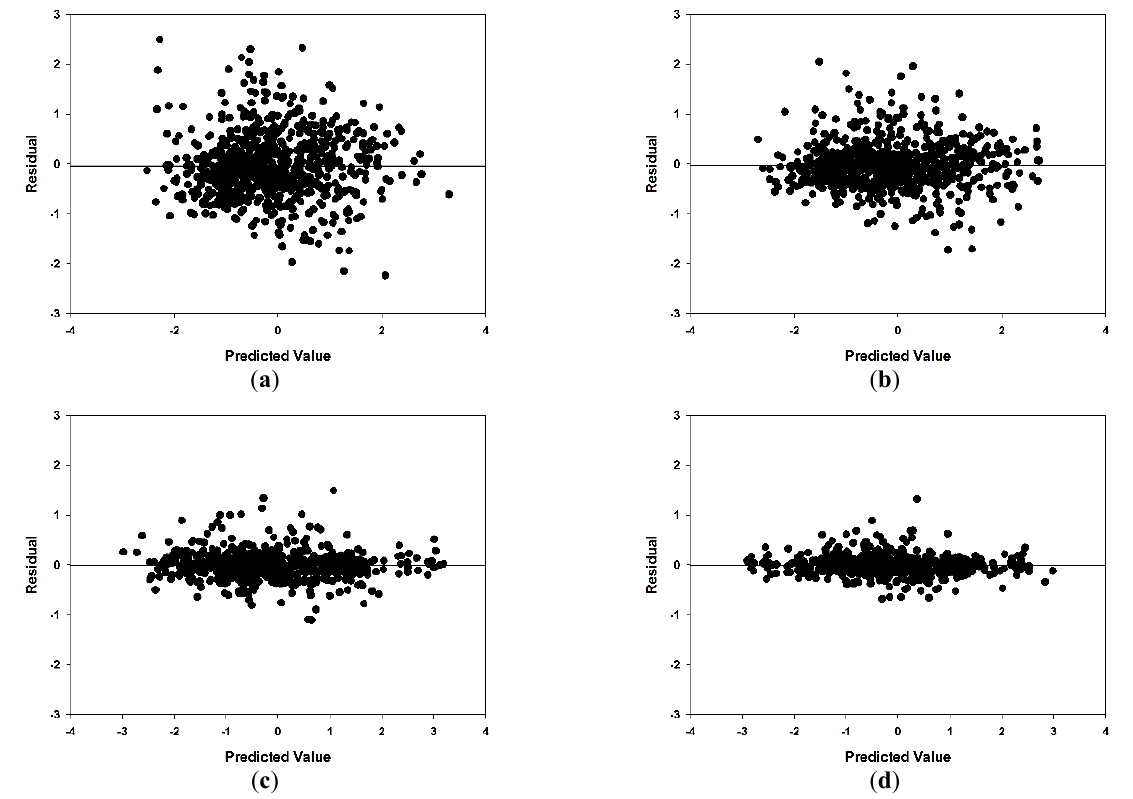
Figure 9. Residuals vs. predicted values of Al Ghazalah City as a best-fitted model for